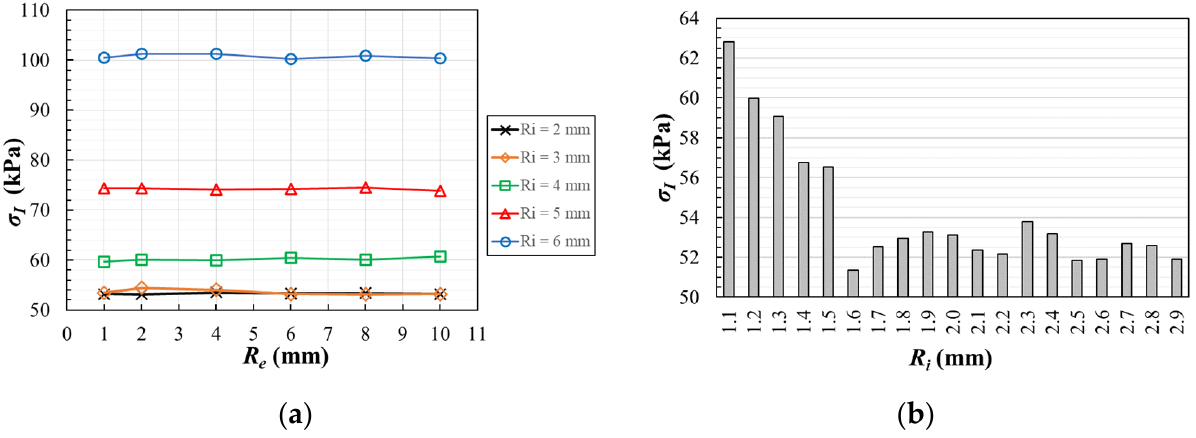
Figure 9. In geometry B: ( a ) The highest value of the maximum principal stress (expressed in absolute value) as a function of the fillet radii. ( b ) For an external radius R e = 1 mm, influence of the internal radius on the maximum principal stress.